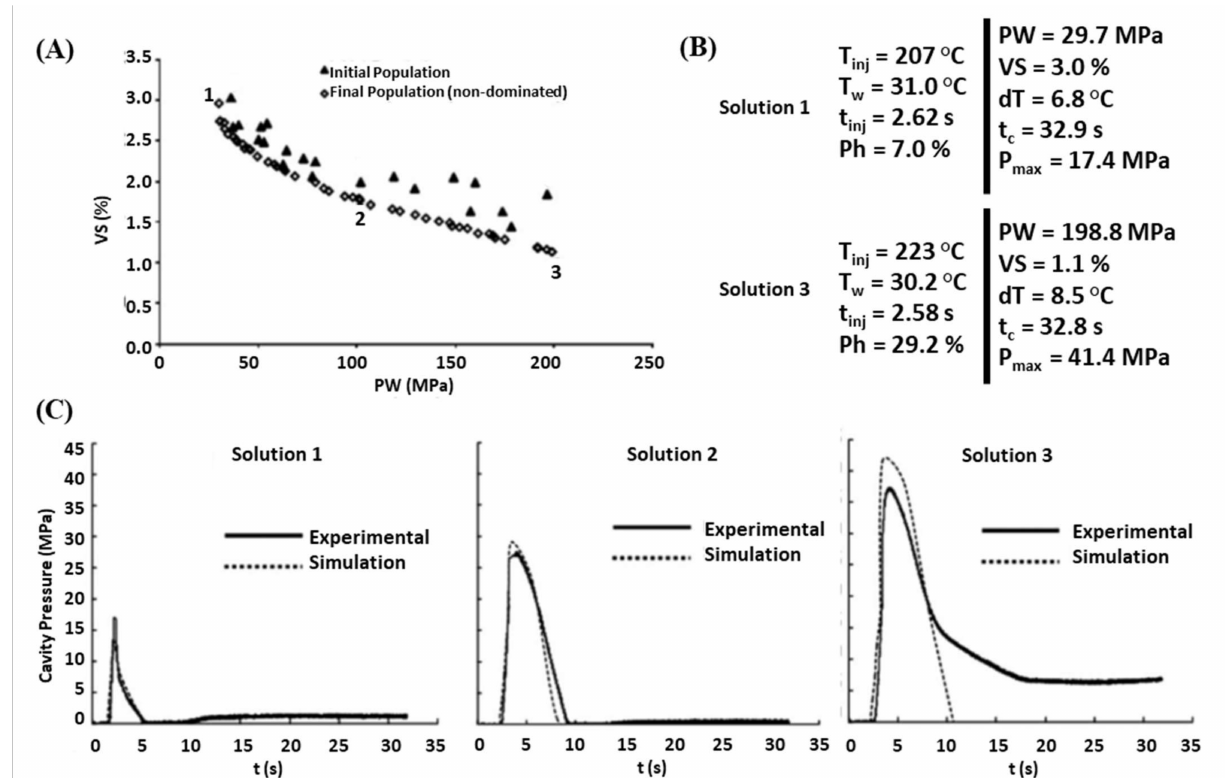
Figure 2. Multi-objective optimization of the operating conditions for injection molding: ( A ) Pareto curves; ( B ) Decision variables and objective values for the optimized solutions; ( C ) Experimental assessment (adapted from [69]).